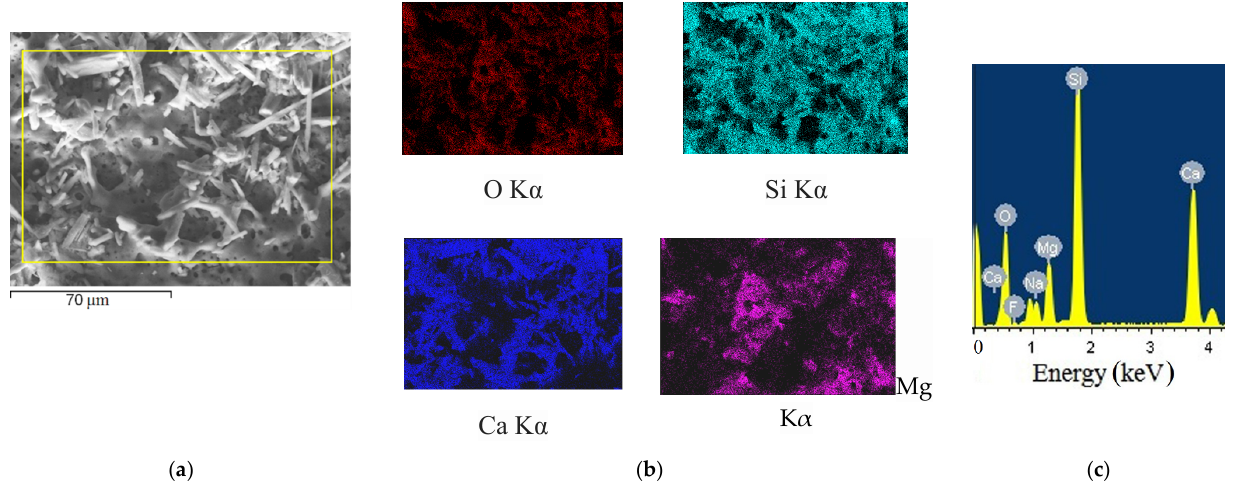
Figure 3. SEM images of the surface ( a , b , d , e ), and cross-sections ( c , f ), of W-coatings deposited at 350 V ( a , d , c ) and 500 V ( b , e , f ).